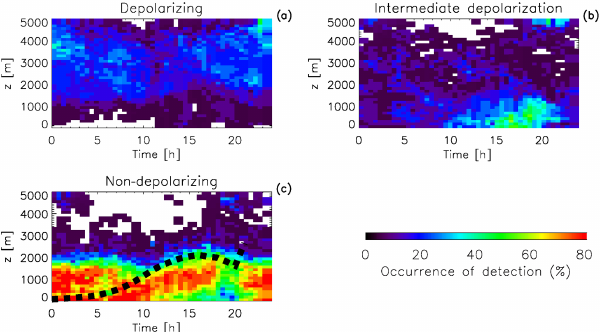
Figure 7. Mean daily frequency of the vertical distribution of each aerosol class (computed as the ratio between the number of aerosol class detections and the number of days of measurements): depo- larizing (a) , intermediate depolarizing (b) and non-depolarizing (c) . The mean PBL height, derived from lidar analysis, is reported as a black dashed line over the non-depolarizing particle